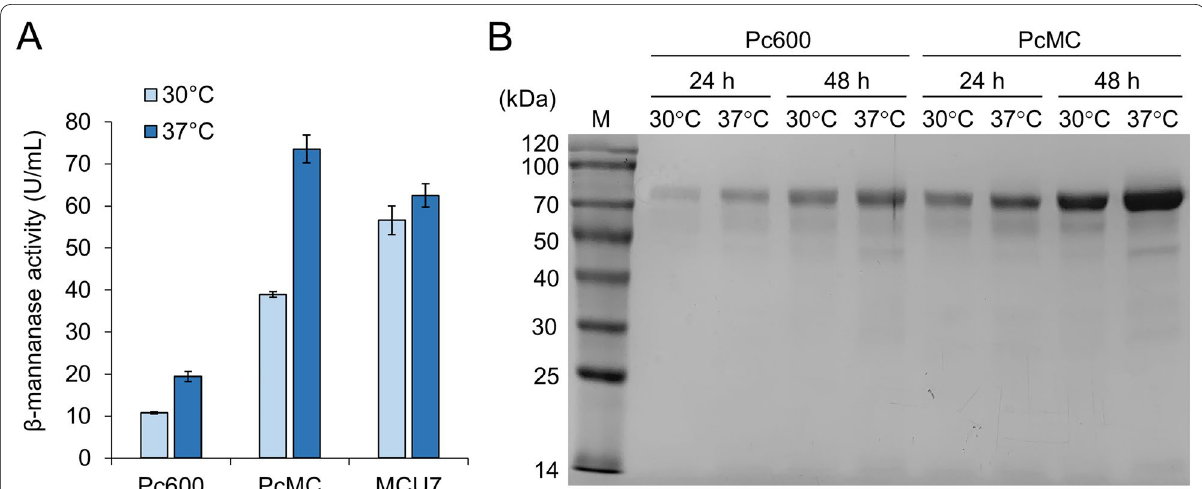
Fig. 4 β-Mannanase production by engineered cdna1 promoters at increased temperature. A Extracellular β-mannanase activities of strains expressing poman5A with different promoters at 48 h. Data represent mean